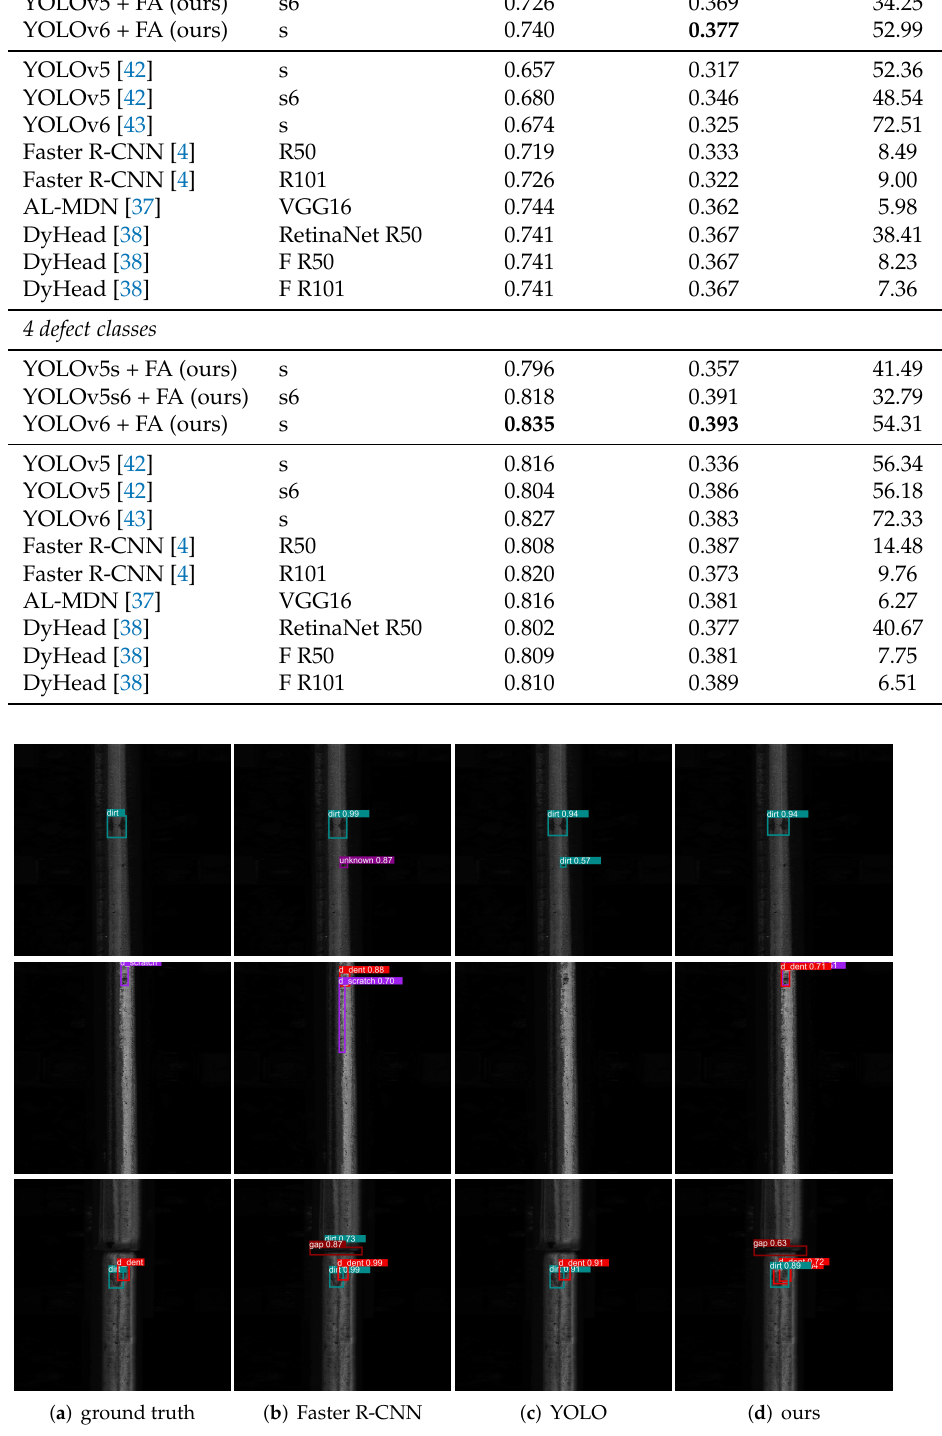
Figure 6. Detection result concerning 8 classes. The four columns corresponds to ( a ) ground truth, ( b ) Faster R-CNN-R101, ( c ) YOLOv5s6, and ( d ) YOLOv5s6 with the proposed FA. Three rows are three different test